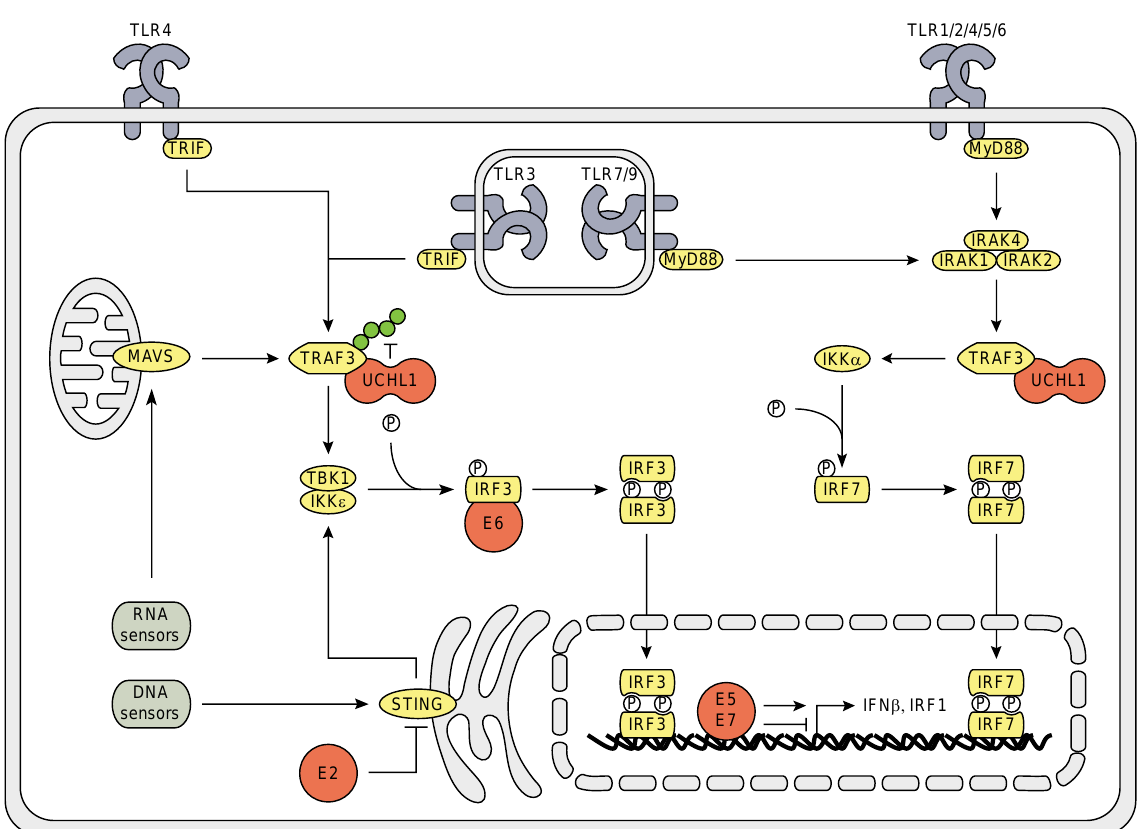
Figure 1. Schematic representation of the effects of hrHPV on IRF signaling. All TLRs, except TLR3, activate IRF7 via signaling through MyD88, the IRAK complex, TRAF3 and IKK α . TLR3 and 4 signal via TRIF, cytosolic RNA sensors through MAVS and cytosolic DNA sensors via STING activate IRF3 through TRAF3, TBK1 and IKK ε . Activated IRFs dimerize, translocate to the nucleus and initiate gene transcription. HPV utilizes its own encoded E proteins (red) as well as exploits the cellular protein UCHL1 (red) to interfere with these signaling pathways. Green circles on TRAF3 indicate K63-linked poly-ubiquitin chains.